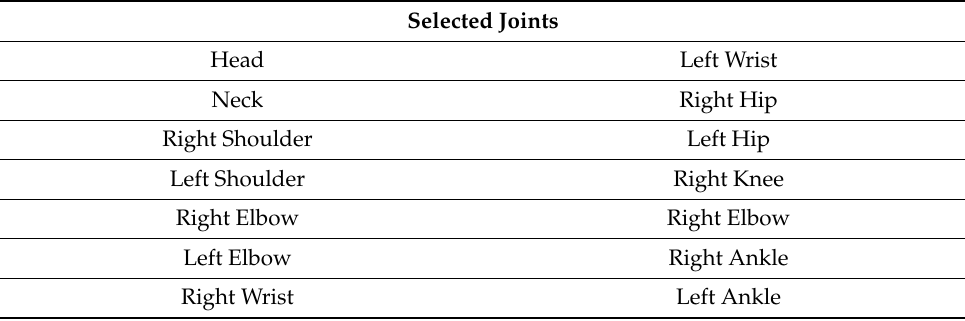
Table 1. The selected joints employed in the proposed methodology.